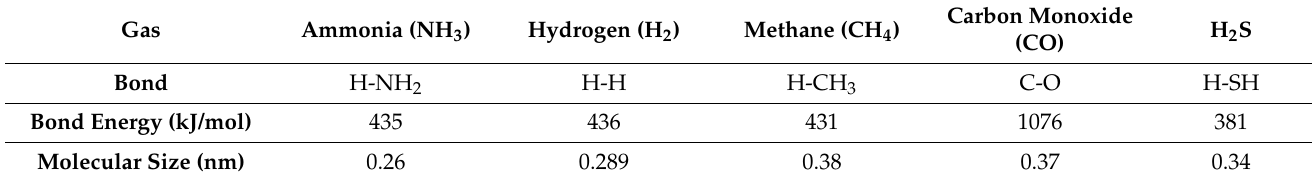
Table 1. Various gas molecules and their properties